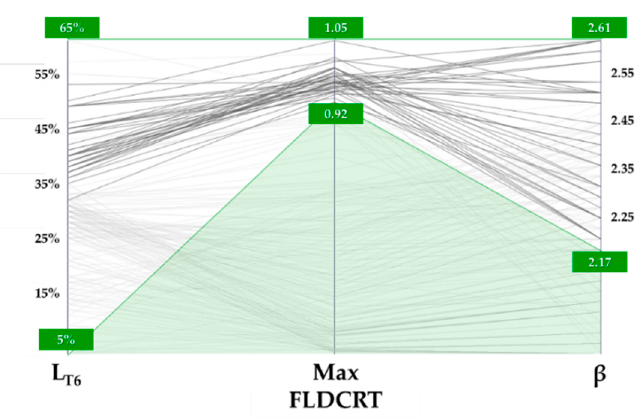
Figure 22. Optimization results: parallel coordinate chart.